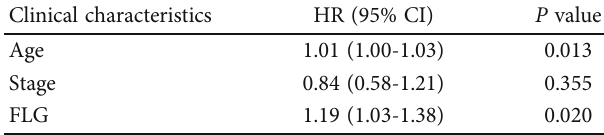
(b) Multivariate survival using Cox regression Clinical